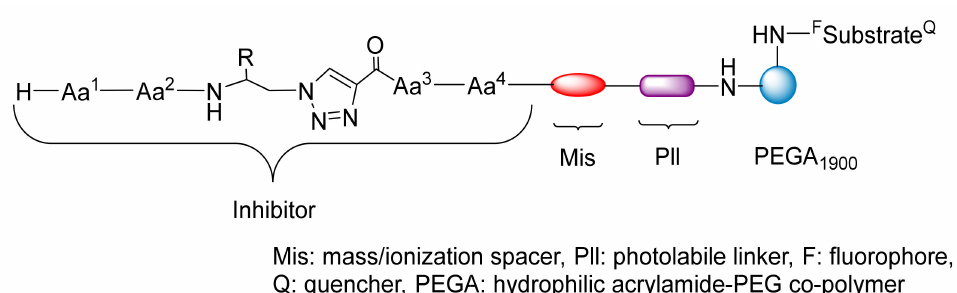
Figure 2. Structure of the peptidotriazole library.